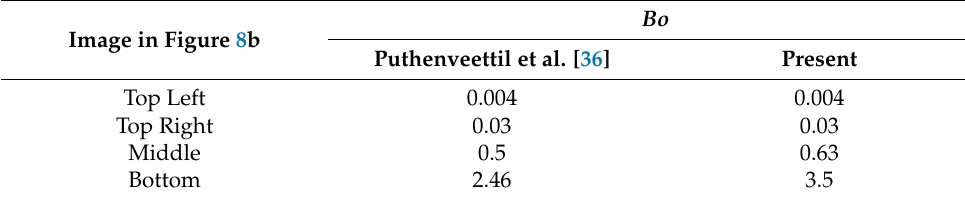
Table 3. The Bond numbers ( B O ) measured by Puthenveettil et al. [36] and those of the present computational